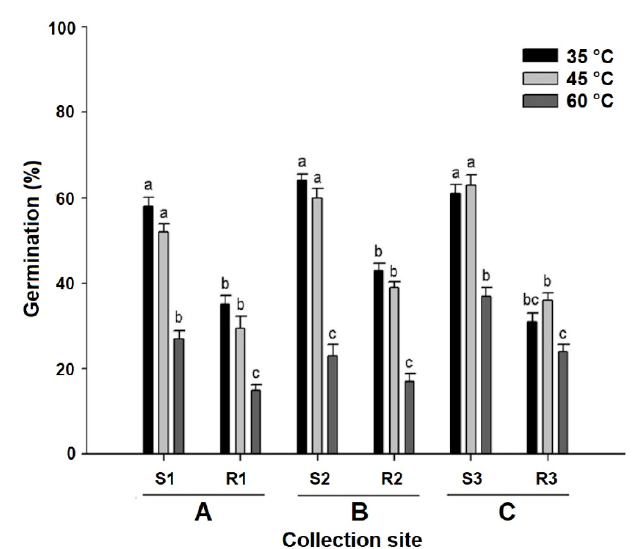
Figure 5. Seed germination under high-temperature stress test for glyphosate-susceptible (S) and -resistant (R) Conyza bonariensis biotypes. Seeds were collected in Passo Fundo-RS ( A ), Palmeira-PR ( B ), and Mat ã o-SP ( C ), Brazil. Vertical lines represent the standard error of means ( n = 4) using 50 seeds per replicate. Di ff erent letters denote statistical di ff erences within a collection site according to the 95% Tukey